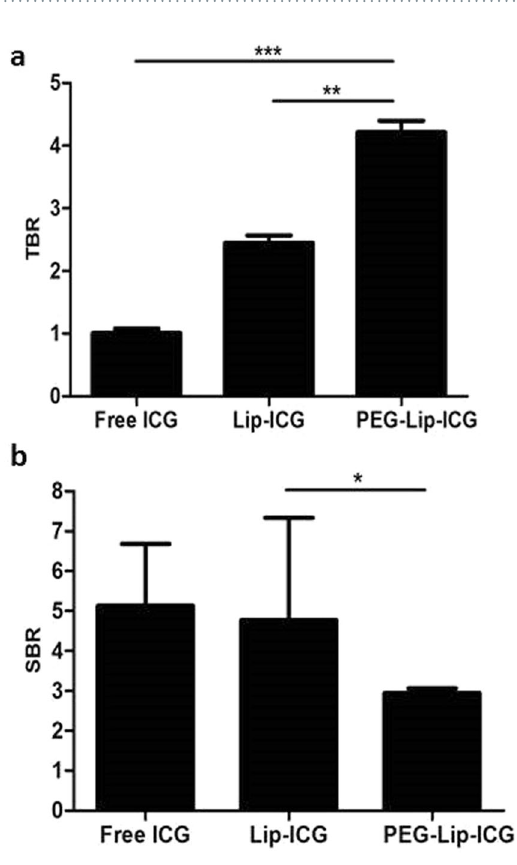
Figure 5. Effect of liposome PEGylation on imaging. ( a ) PEGylated liposome (PEG-Lip-ICG) yielded a significantly higher tumor to background ratio (TBR) when compared with Lip-ICG (4.2 ± 0.18 vs. 2.5 ± 0.12, respectively, p < 0.01). ( b ) Uptake by the reticulo-endothelial system (determined by splenic uptake of the fluorophore, measured as signal-to-background ratio, SBR) showed decreased uptake of PEG-Lip-ICG compared with Lip-ICG (2.95 ± 0.12 vs 4.8 ± 2.3, respectively, p < 0.05). Results from one experiment, n = 5 for each group. The signal intensity was determined 12 hours after i.v.